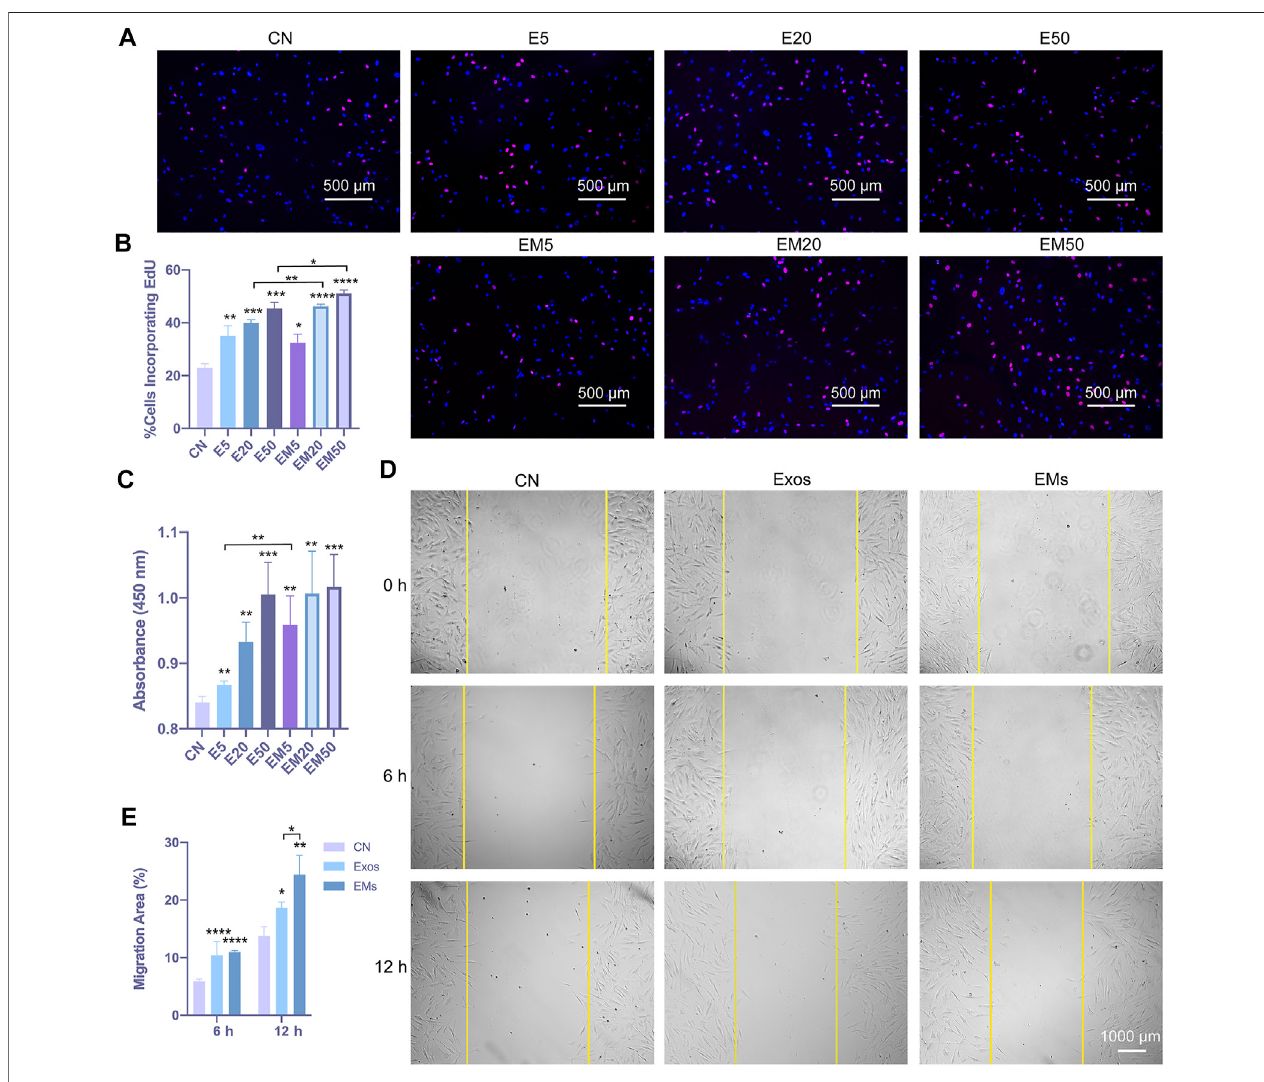
FIGURE2| The effect ofhUMSC-derived exosomes and EMsonthe proliferation and migration ofhDF-a cells invitro (CN =control, E5=exosome5 μ g/ml, E20 = exosome20 μ g/ml, E50 =exosome50 μ g/ml, EM5 = EMs 5 μ g/ml, EM20 = EMs 20 μ g/ml, EM50= EMs50 μ g/ml). (A) hUMSC-derived exosomes and EMspromoted proliferationofhDF-abyEdUincorporationassays.Cellnucleiwerestainedblue.Aftertheimagesaremerged,proliferatingcellswerecounterstainedpurplewithanEdU probe. (B) QuantitativeanalysisoftheEdUincorporationassays( n =4,* p < 0.05,** p < 0.01,*** p < 0.001,**** p < 0.0001). (C) hUMSC-derivedexosomesandEMs promoted the proliferation of hDF-a cells as shown in CCK-8 assays. ( n = 4, * p < 0.05, ** p < 0.01) (D) A scratch assay veri fi ed the migration of hDF-a cells in vitro by hUMSC-derived exosomes and EMs. (E) Quantitative analysis of scratch assays ( n = 4, * p < 0.05, ** p < 0.01, **** p < 0.0001).